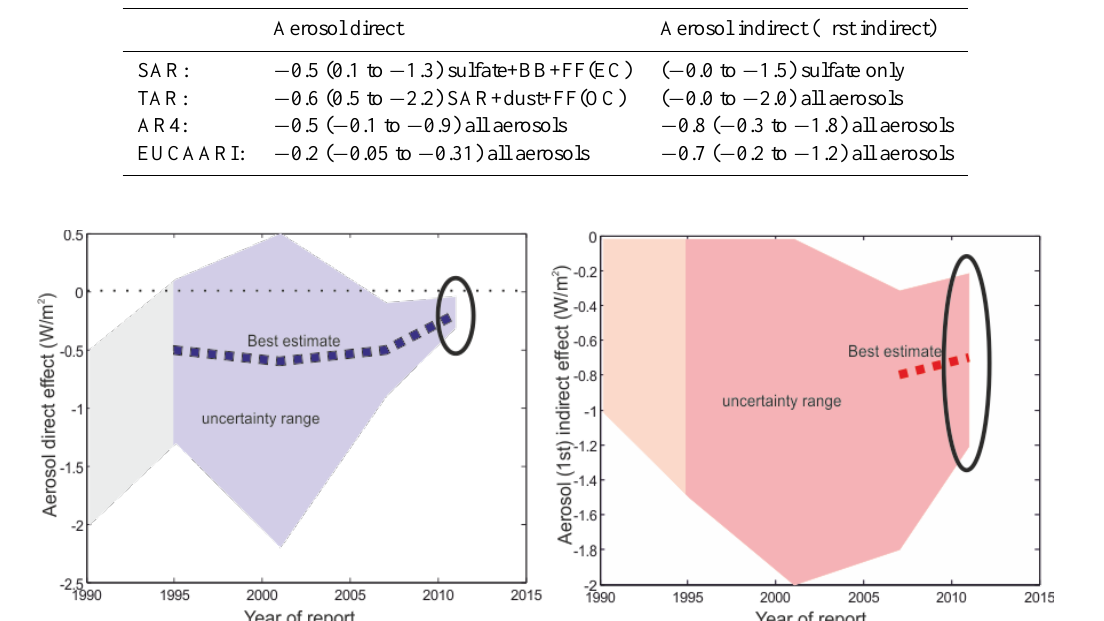
Fig. 20. The upper and lower limit and the best estimate for radiative forcing based on IPCC results and our own estimate denoted by 2010 for direct effect (left) and for 1st indirect effect (right).